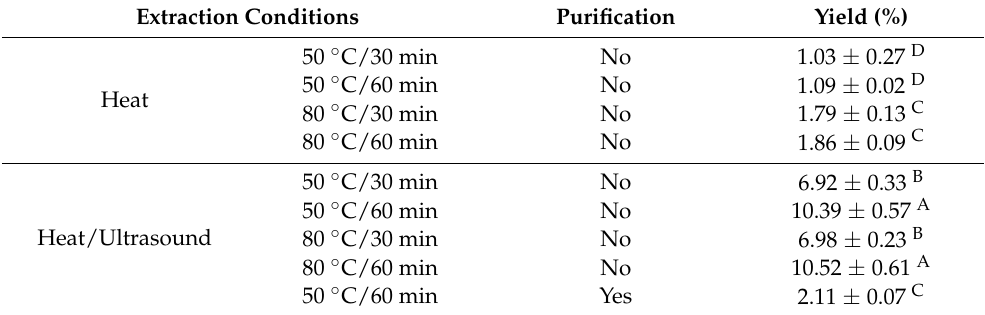
Table 1. The yield of chia seed mucilage extracted with different combinations of ultrasound and heat.